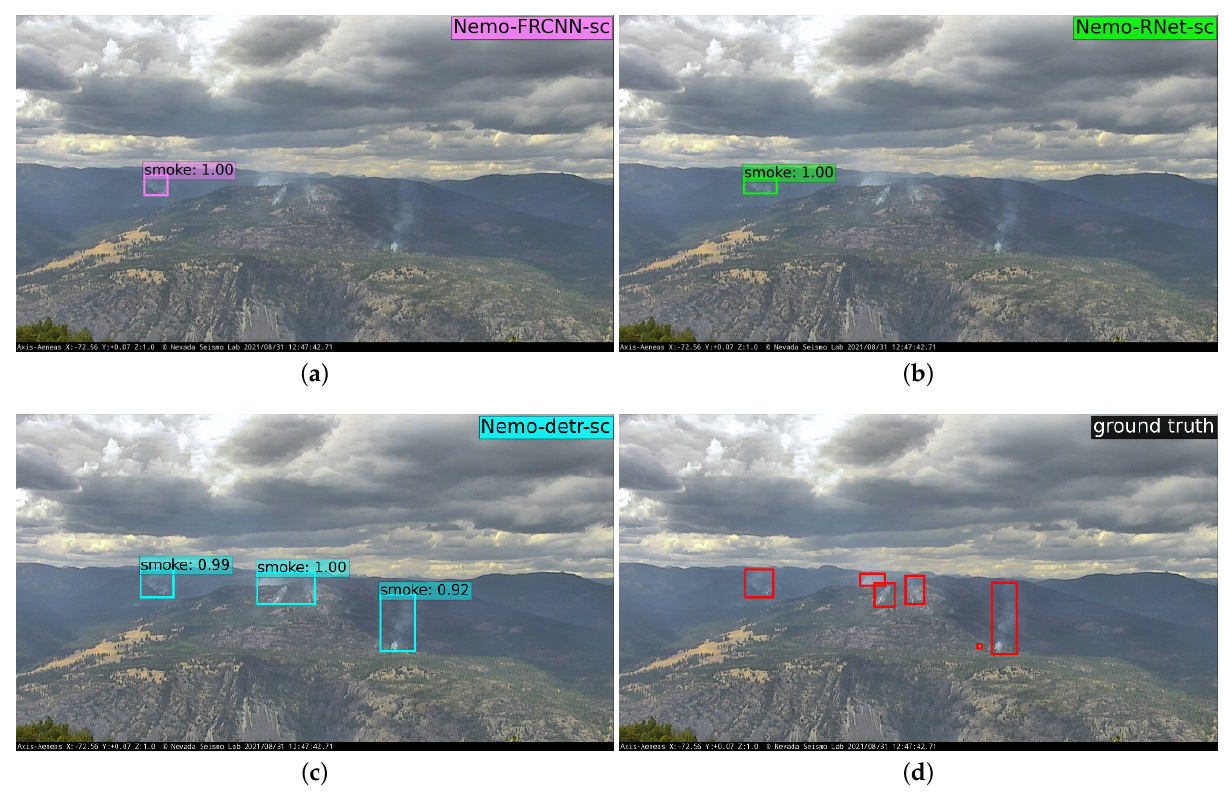
Figure 11. Wildfire single-class smoke bounding box predictions by ( a ) Faster R-CNN (Nemo- FRCNN-sc), ( b ) RetinaNet (Nemo-RNet-sc), and ( c ) DETR (Nemo-DETR-sc). ( d ) shows the ground truth annotation. The image shown is from a camera at Aeneas Lookout, Washington, 31 August